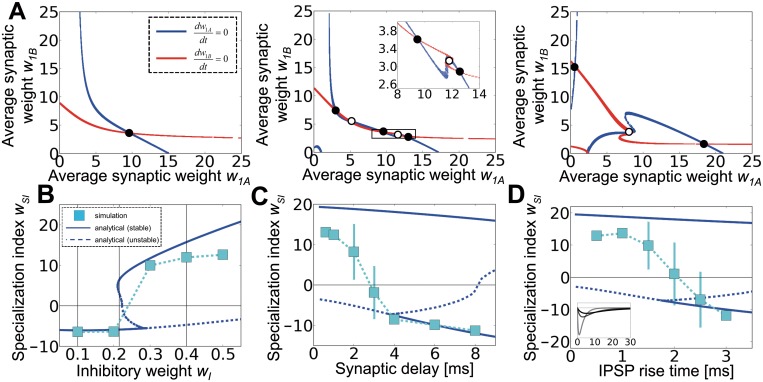
Lateral inhibition is strong, fast, and sharp.(A) Nullclines of the average synaptic weight changes at different inhibitory amplitudes w
Z = 0.1, 0.215, 0.4. The inset in the middle graph is a magnified view of boxed area. (B) Specialization indices w
SI for various inhibitory weights. Positive w
SI indicates the winner-share-all state, whereas negative w
SI indicates the winner-take-all state. Blue lines are analytical estimations and cyan squares are the results of simulations. Vertical lines correspond to the values at which the nullclines in Figure A are calculated. (C) The same graphs for various synaptic delays. The average synaptic delay of both lateral excitatory (dYmin+dYmax)/2 and inhibitory (dZmin+dZmax)/2 connections was changed, while the variability was kept at dYmax—dYmin = dZmax—dZmin = 1.0 ms. (D) IPSP rise time dependence. The inset shows IPSP curves at {τZ
A, τZ
B} = {0.5, 2.5} (gray line), {1.5, 7.5} (dark gray line), and {2.5, 12.5} (black line).